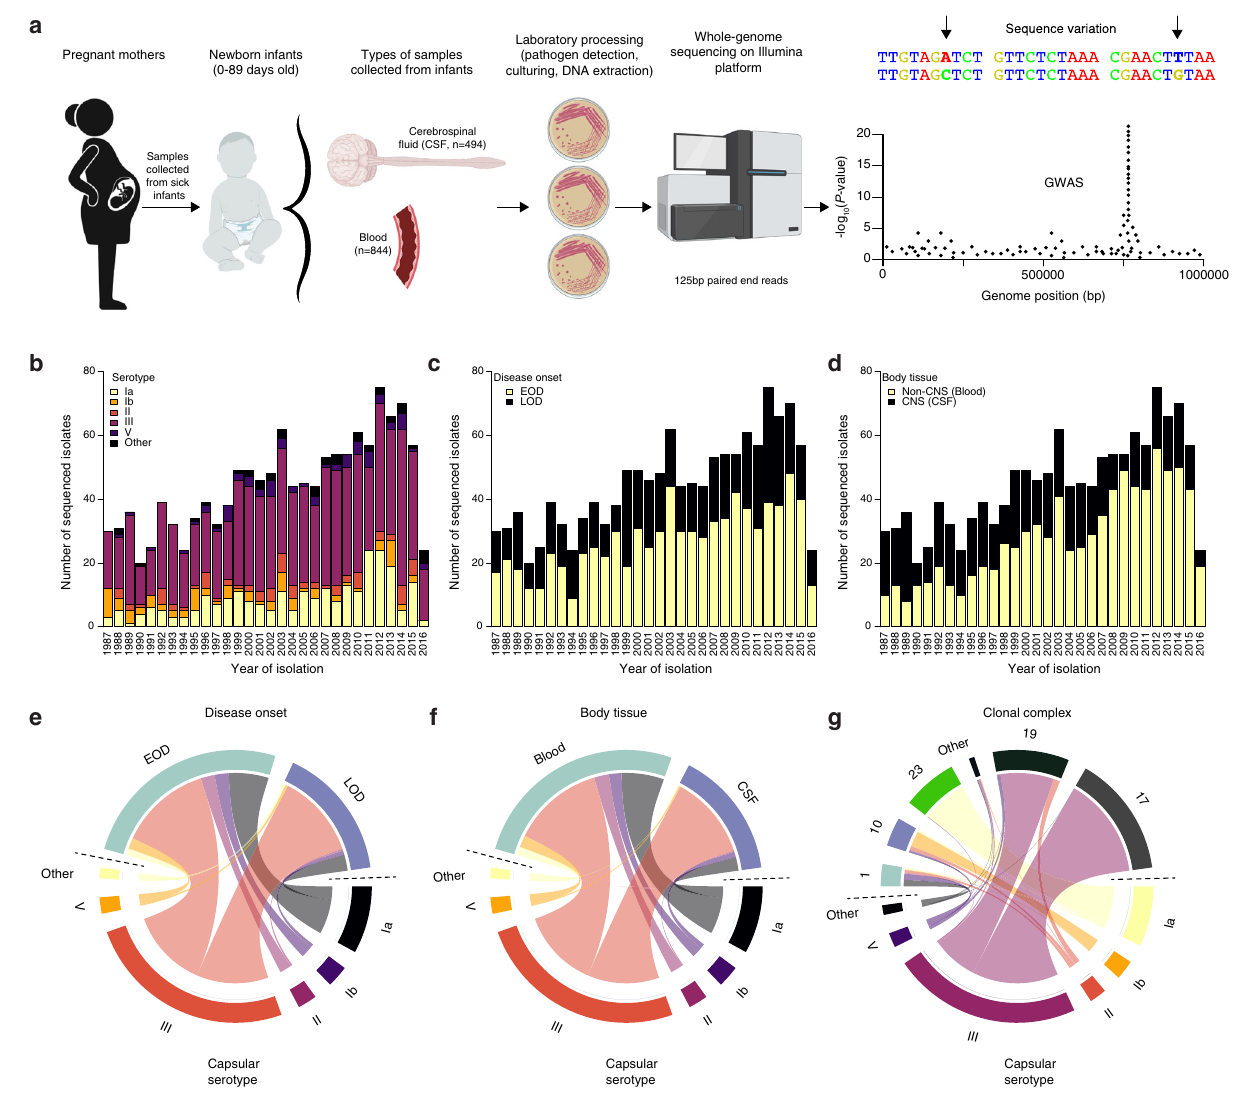
Fig. 1 Study design and characteristics of the 1,338 GBS isolates sampled from newborns over 30 years. a Schematic diagram showing sample collection and study design. GBS samples were collected annually for 30 years, 1987 – 2016, from blood and cerebrospinal fl uid (CSF) of newborns aged 0 – 89 days through a national bacterial surveillance programme in the Netherlands. The samples were processed as described in the methods, and whole genomes were sequenced on the Illumina HiSeq platform with 125 bp reads for downstream analyses, particularly GWAS. The number of sequenced GBS isolates annually is strati fi ed by the b proportion of serotypes, c proportion of isolates classi fi ed as EOD and LOD. d proportion of isolates by isolation tissue. The total number of sequenced GBS isolates strati fi ed by e disease onset time and capsular serotype, f isolation tissue and capsular serotype, and g clonal complex and capsular serotype. The icons in panel a were created with permission in BioRender.com (https://biorender.com/). Source data used to generate fi gures in panel b – g is available in Supplementary Data frequency among isolates sampled from the CNS than from non- CNS sites (odds ratio: 3.62, P = 1.75 × 10 − 25 ). Conversely, the among CNS isolates than among non-CNS isolates (Fig. 3d – f).